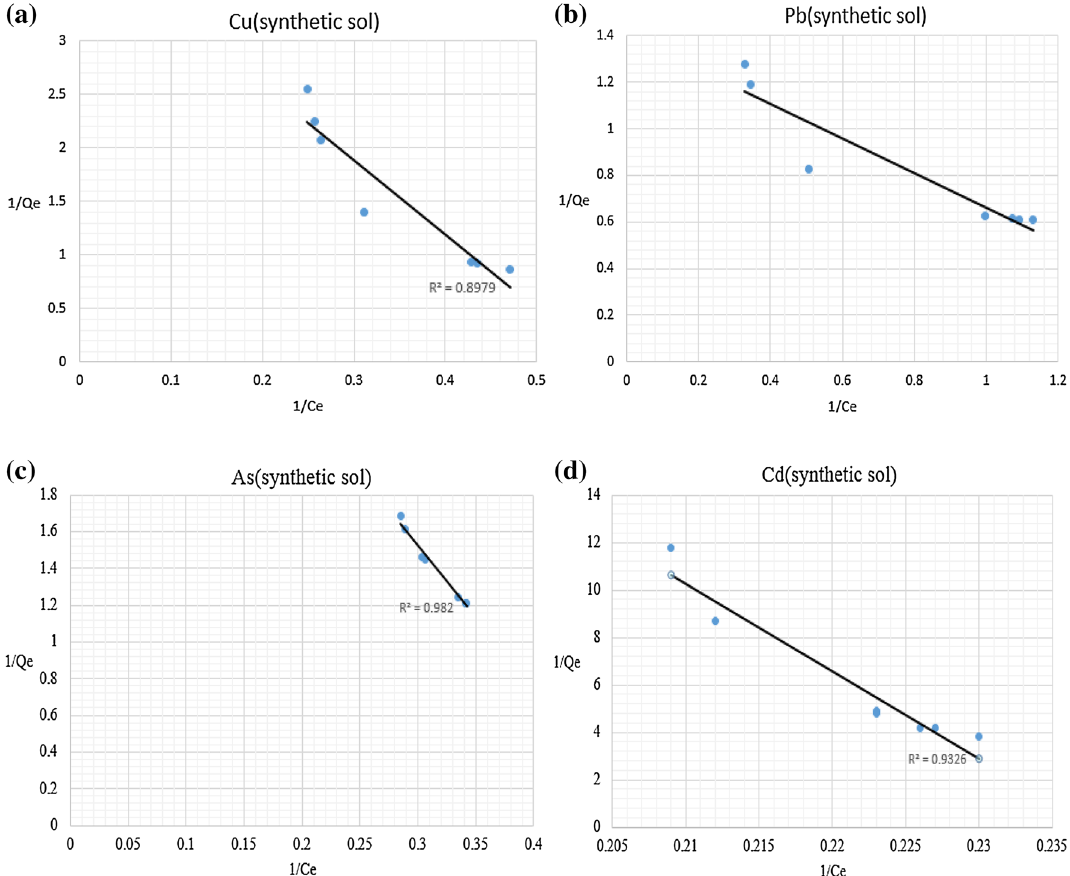
Fig. 7 Langmuir isotherm model for adsorption of heavy metals in synthetic solution at different proportions of B:C bioadsorbent. a Cu, b Pb, c As, d